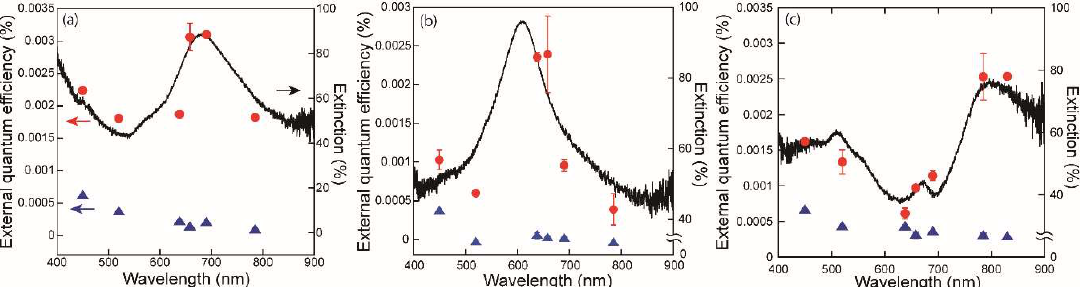
Figure 2. Plasmonic nanohole array extinction spectra and quantum efficiencies. Measured spectra : ( a ) 300, ( b ) 250, and ( c ) 400 nm. Measured external quantum efficiencies of plasmonic photo-thermoelectric conversion, for illuminations of the nanohole array (red circles) and for illumination of a reference position (blue triangles), are also plotted for each array on the respective panels.